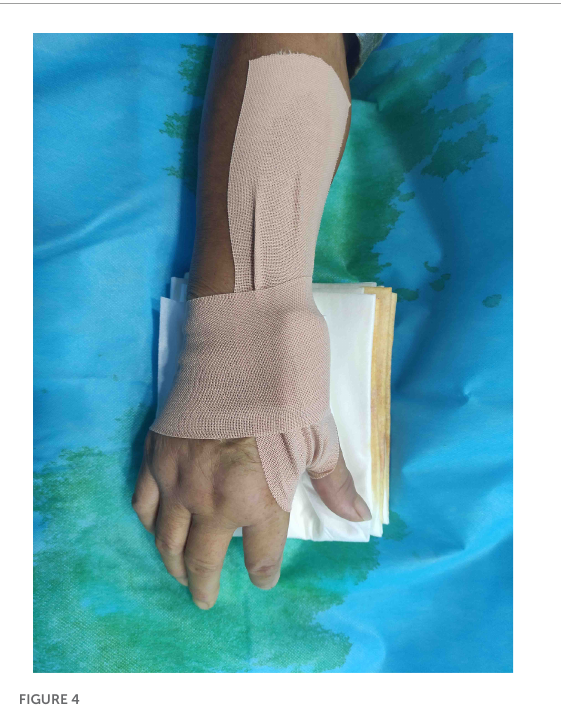
FIGURE3 Gauze bandage for hemostasis.